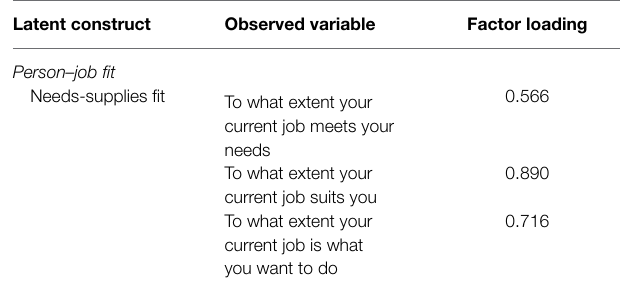
TABLE 2 | Standardized factor loadings of the observable